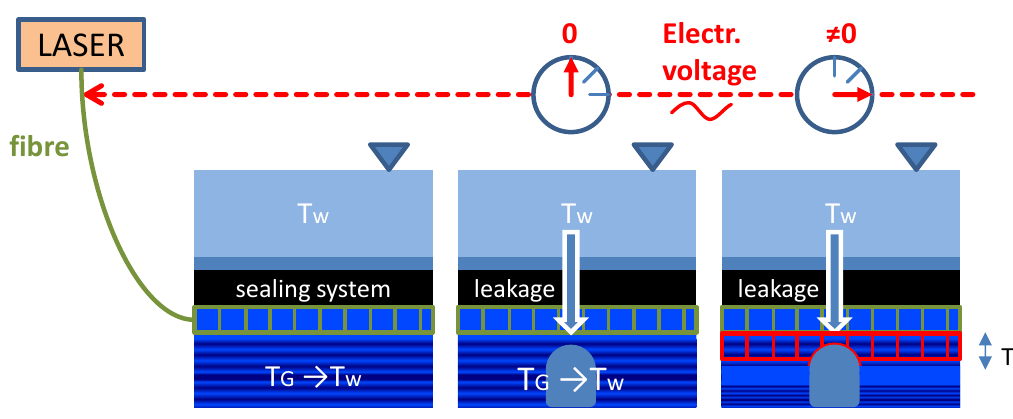
Figure 11. Heat-pulse method of leakage detection